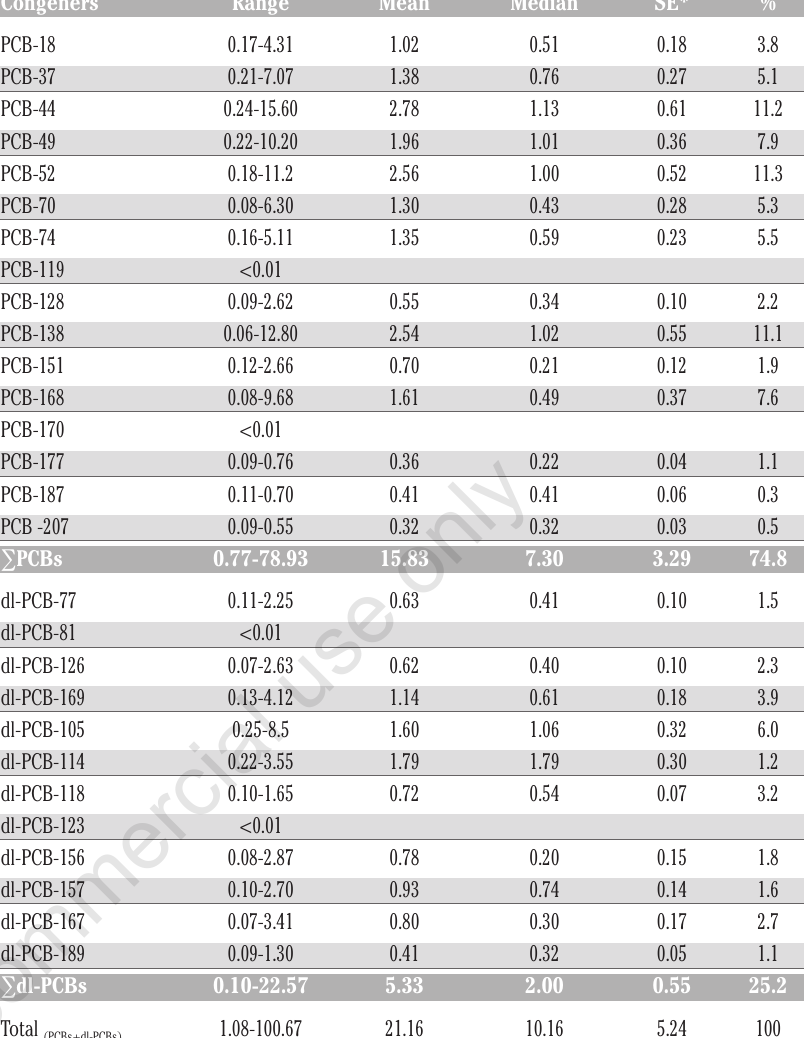
Table 2. Polychlorinated biphenyl congener concentrations (ng/g dw) in urban soils from Delhi, India. Congeners